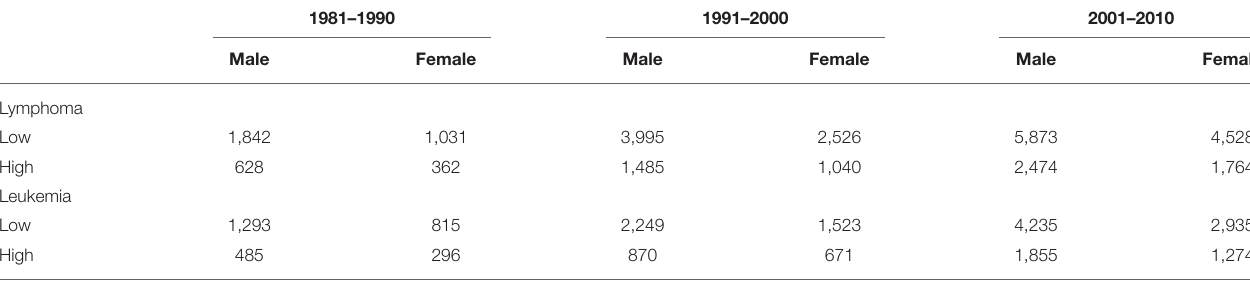
TABLE 1 | The number of incident cases of lymphoma and leukemia by sex and exposure category in three consecutive 10-year time periods.